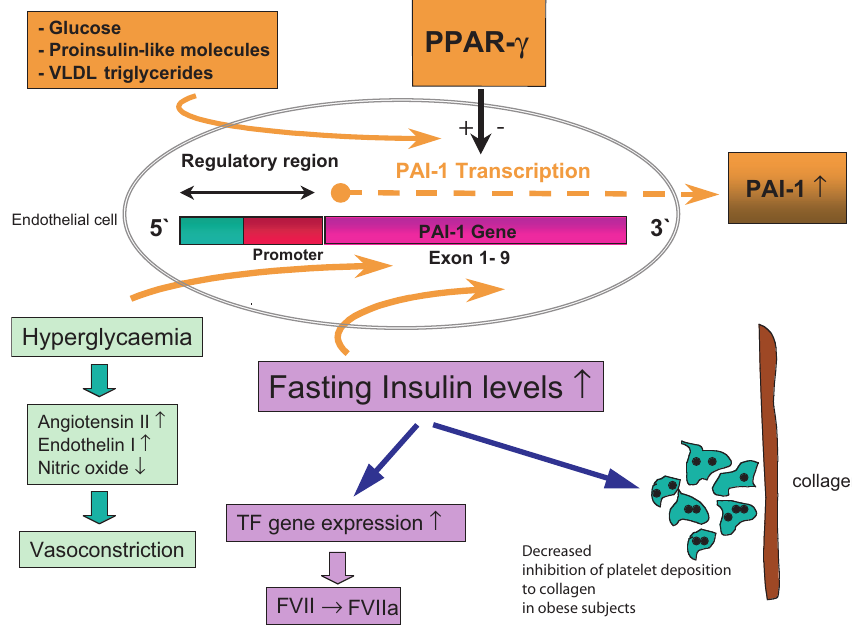
Features of insulin resistance: Interaction with PAI-1 and TF gene expression, platelet activa- tion and vascular tone. Glucose, proinsulin-like molecules and VLDL triglycerides increase PAI-1 transcription in endothelial cells and therefore lead to increased PAI-1 plasma con- centrations. Peroxisomal proliferator-activated receptor-gamma (PPAR- g ) may also regulate PAI-1 expression in human endothelial cells. Hyperglycaemia not only induces PAI-1 tran- scription but also leads to an increase in an- giotensin II and endothelin I and a decrease in nitric oxide, therefore leading to vasoconstric- tion. Increased fasting insulin levels induce tissue factor (TF) gene expression and a de- crease in platelet inhibition, both leading to a procoagulant state. Tissue factor activates FVII to FVIIa. This initiates the coagulation process of the extrinsic